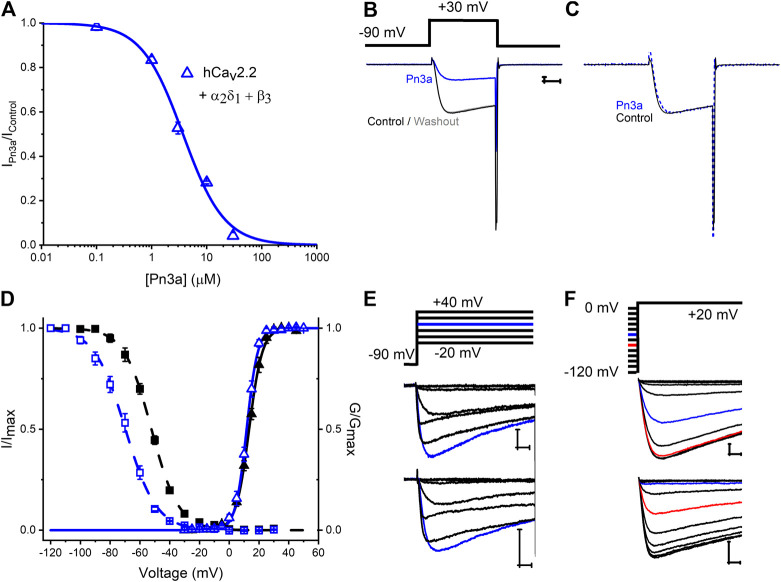
Characterization of Pn3a effects on Human Cav2.2 channel-mediated currents. (A) Pn3a inhibition of hCav2.2 currents is described by the concentration-response curve. Hill equation fit gives an IC
50 = 3.70 ± 0.21 µM, and nH = 1.16 ± 0.07 (n = 5 for each concentration). (B) Representative current traces of hCav2.2 (β3/α2δ1) recorded in control (black), 10 µM Pn3a (blue), and after peptide washout (gray). (C) Normalized peak currents from (B) in control (black, solid) and Pn3a (blue, dotted). (D) Effect of Pn3a on the voltage dependent kinetics of Cav2.2. Activation (triangles) and steady-state inactivation (squares) relationships for hCav2.2 obtained in the absence (▲, ■) and presence of 3 µM Pn3a (△, ⊚). (E) Representative currents elicited by the voltage protocol (top) in the absence (control, middle) and presence of 3 µM Pn3A (bottom) normalized to peak I-V currents (blue trace, +20 mV) used to generate activation curves shown in (D). (F) Representative currents from steady-state inactivation (SSI) protocol (top) obtained in the absence (control, middle) and presence of 3 µM Pn3a used to generate SSI curves shown in (D). X scale bar 5 msec; Y scale bar 0.5 nA.